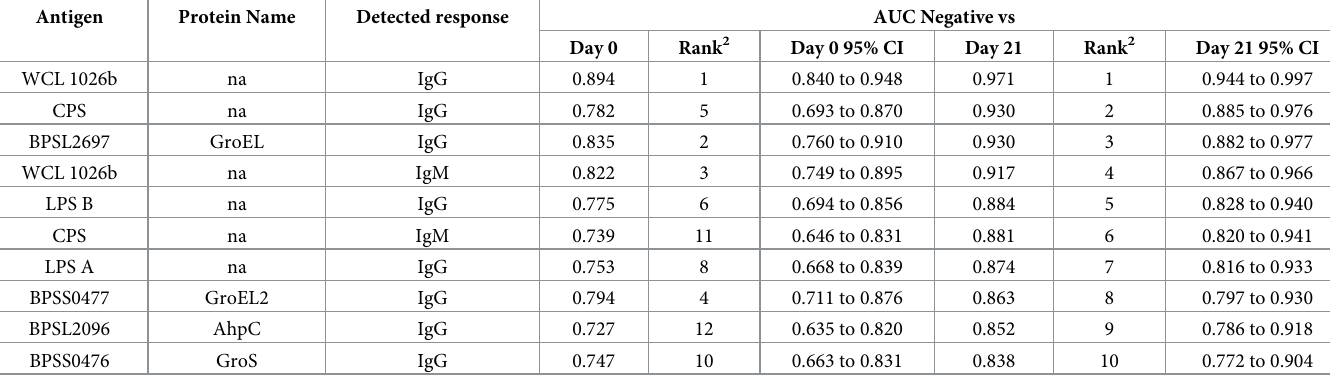
Table 2. AUC Summary statistics of the top 10 individual or multiple antigens as determined by day 21 samples 1 . Antigen